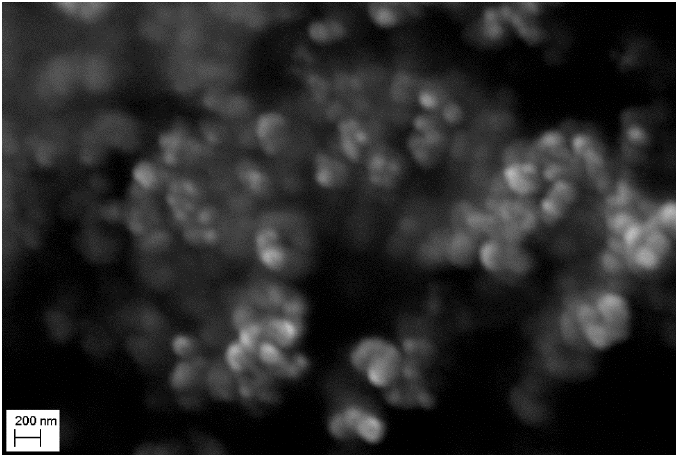
Figure 5. Scanning electronic microscopy (SEM) image of the TiO 2 NPs.